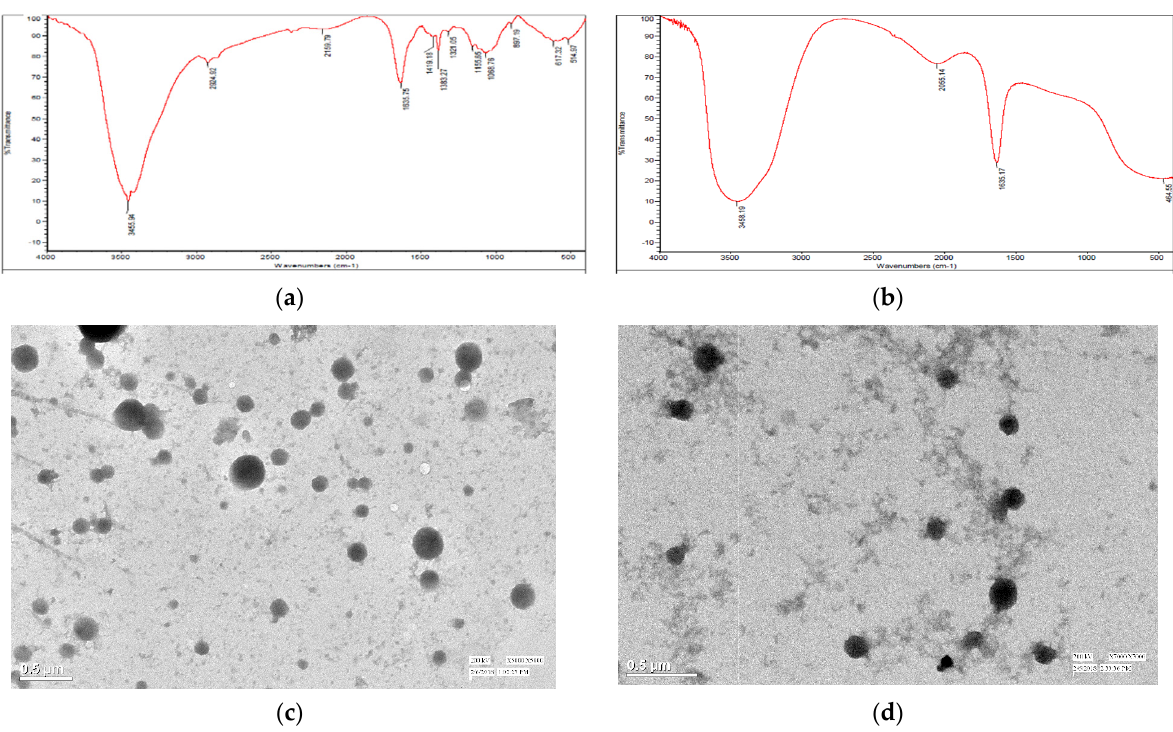
Figure 2. Fourier transform infrared spectra and TEM micrographs of conjugated nanoparticles; FTIR spectra of ( a ) gum acacia, ( b ) mancozeb-loaded NPs, ( c ) TEM micrograph (at 200 kV, ×5000 magnification, 0.5 µ m scale bar) of blank NPs, ( d ) TEM of mancozeb-loaded NPs (at 200 kV, X7000 magnification, 0.5 µ m scale).